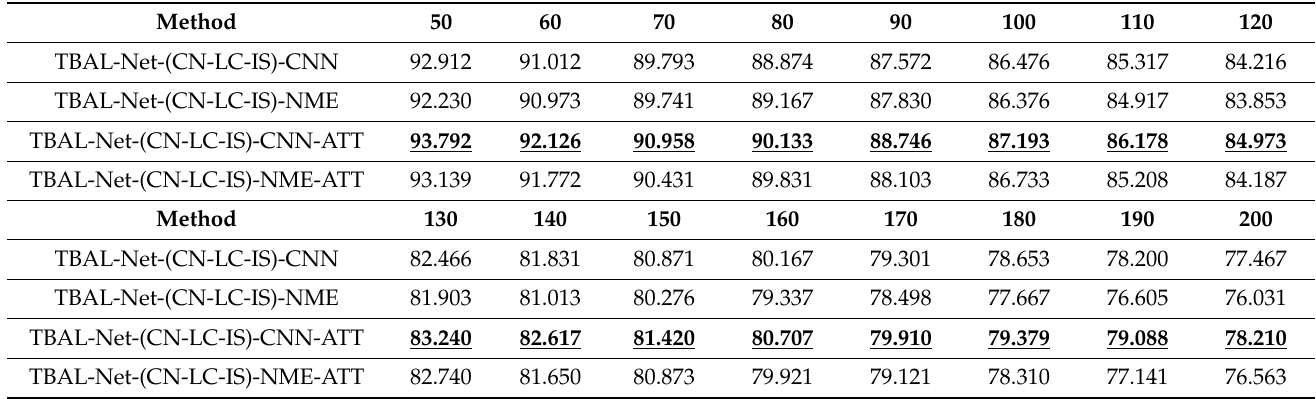
Table 2. Performance of TBAL-Net with/without attention modules on CUB-200-2011 (Top-1 Accuracy). The highest score in each column is marked in bold.